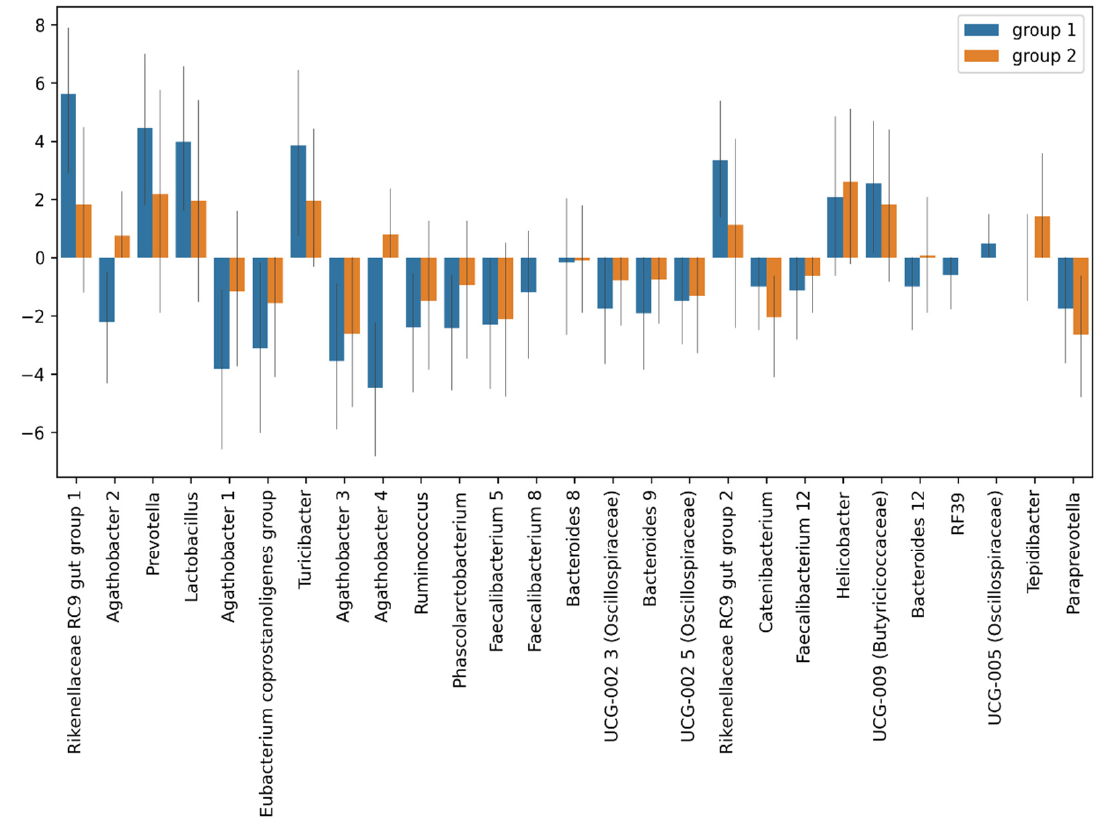
Figure 11. Fold changes in the relative abundance of the post-TBI gut microbiota species in Group 1 (blue) and Group 2 (red).